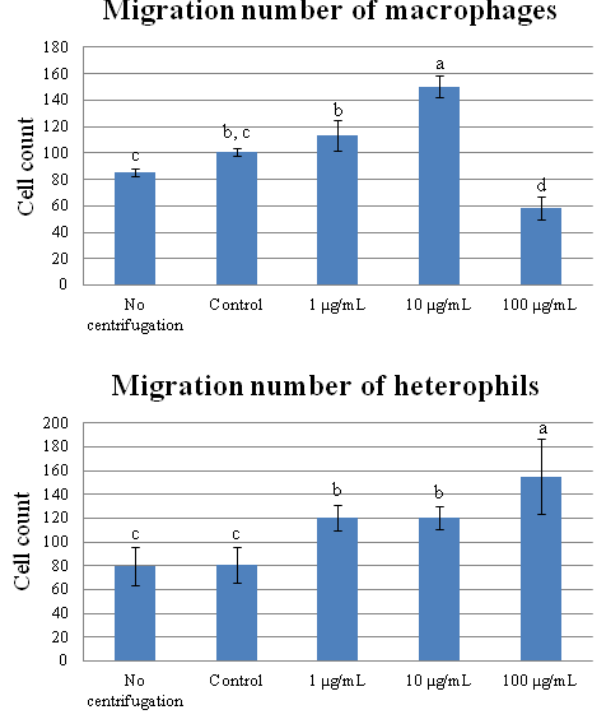
Figure 9. Carbon nanotube treatments enhance migration of chicken macrophages and heterophils. The chicken macrophages and heterophils were added to the upper chambers of inserts containing 5.0 μ m pore membranes and incubated at 37 °C for 40 min. Values are the mean ± SE of three batches. a–c The means with different superscripts differ significantly ( p < 0.05).